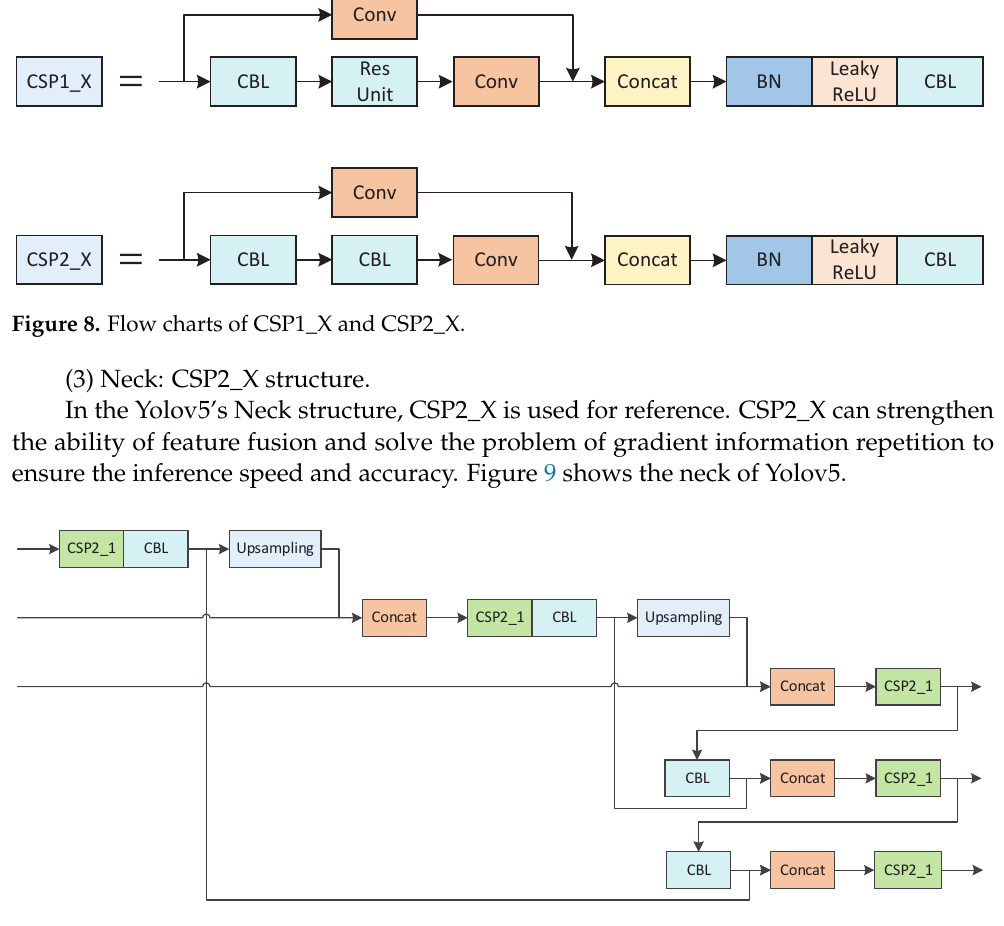
Figure 9. Neck of Yolov5. (4) Prediction: GIOU